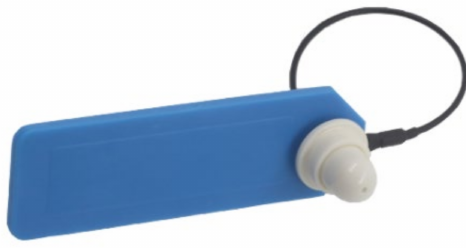
Figure 11. The attached UHF RFID Tag.